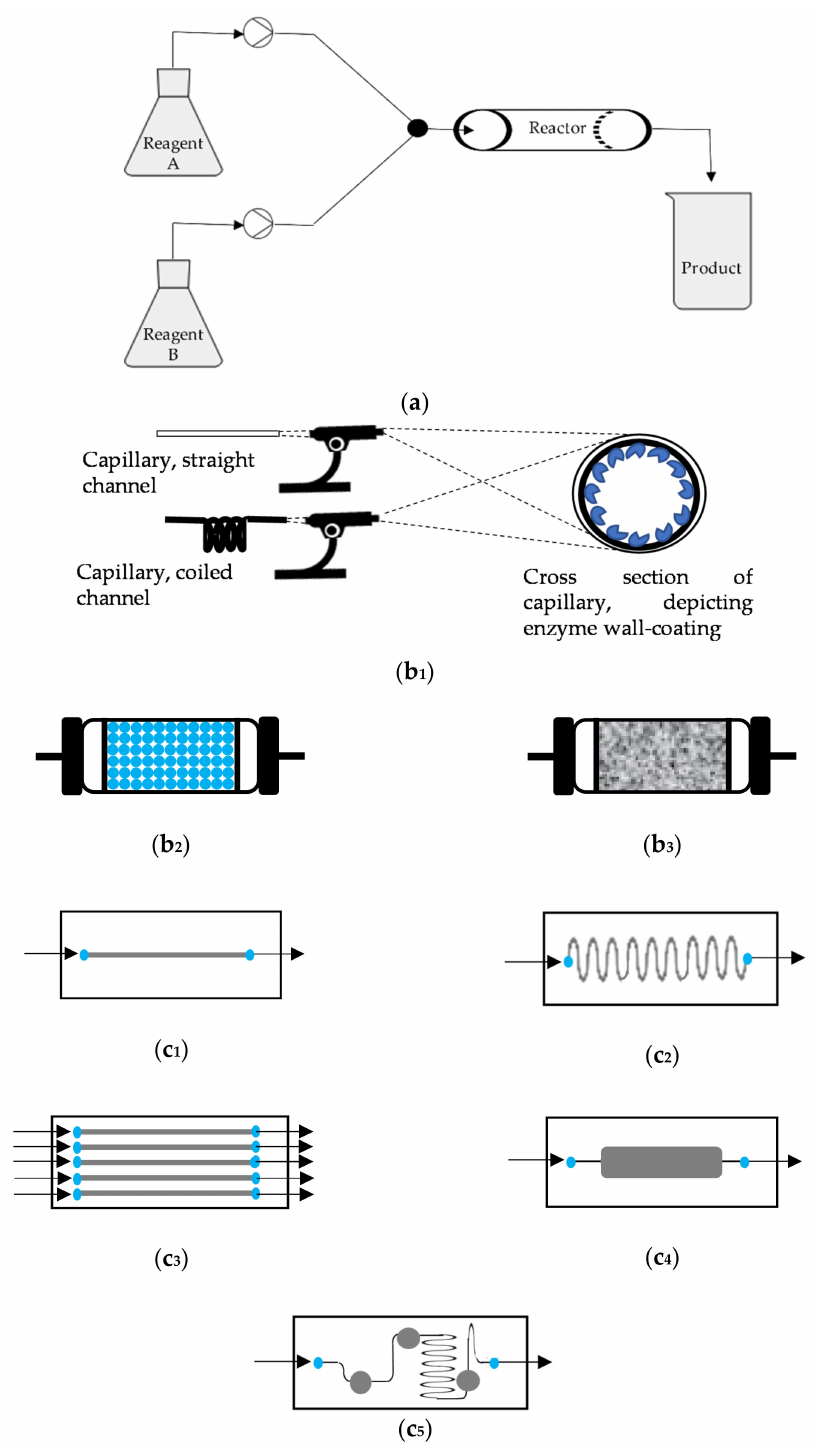
Figure 1. Different types of reactors that are used for biocatalytic reactions carried out under continuous operation in flow chemistry with immobilized biocatalysts. ( a ) Basic configuration, where reagents are continuously pumped into a reactor containing the immobilized biocatalyst. The reactor can be a tubular type of reactor, such as ( b 1 ) open tubular, capillary wall-coated vessel, either as straight channel or coiled; ( b 2 ) packed-bed reactor; ( b 3 ) monolith reactor; or chip-type reactor with ( c 1 ) straight channel; ( c 2 ) serpentine channel; ( c 3 ) multiple channels; ( c 4 ) inclusion of single chambers; ( c 5 ) inclusion of multiple chambers. In c 1 – c 5 , gray areas correspond to reaction zones where biocatalysts are